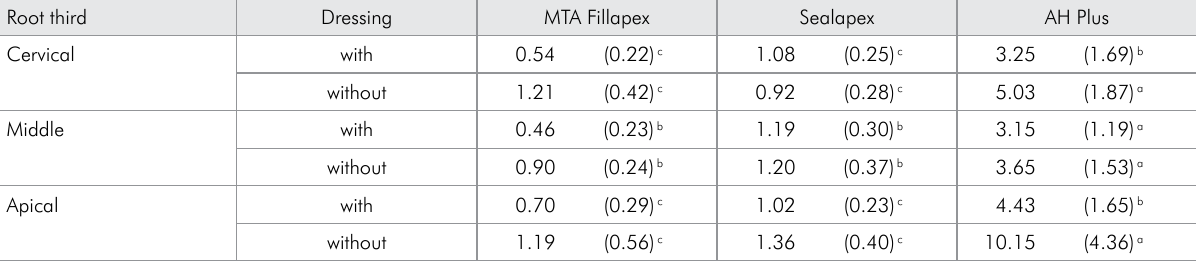
table 2. Mean push-out bond strength values and standard deviation (in MPa) for tested sealers at different root thirds, with or without prior application of calcium hydroxide intracanal dressing.